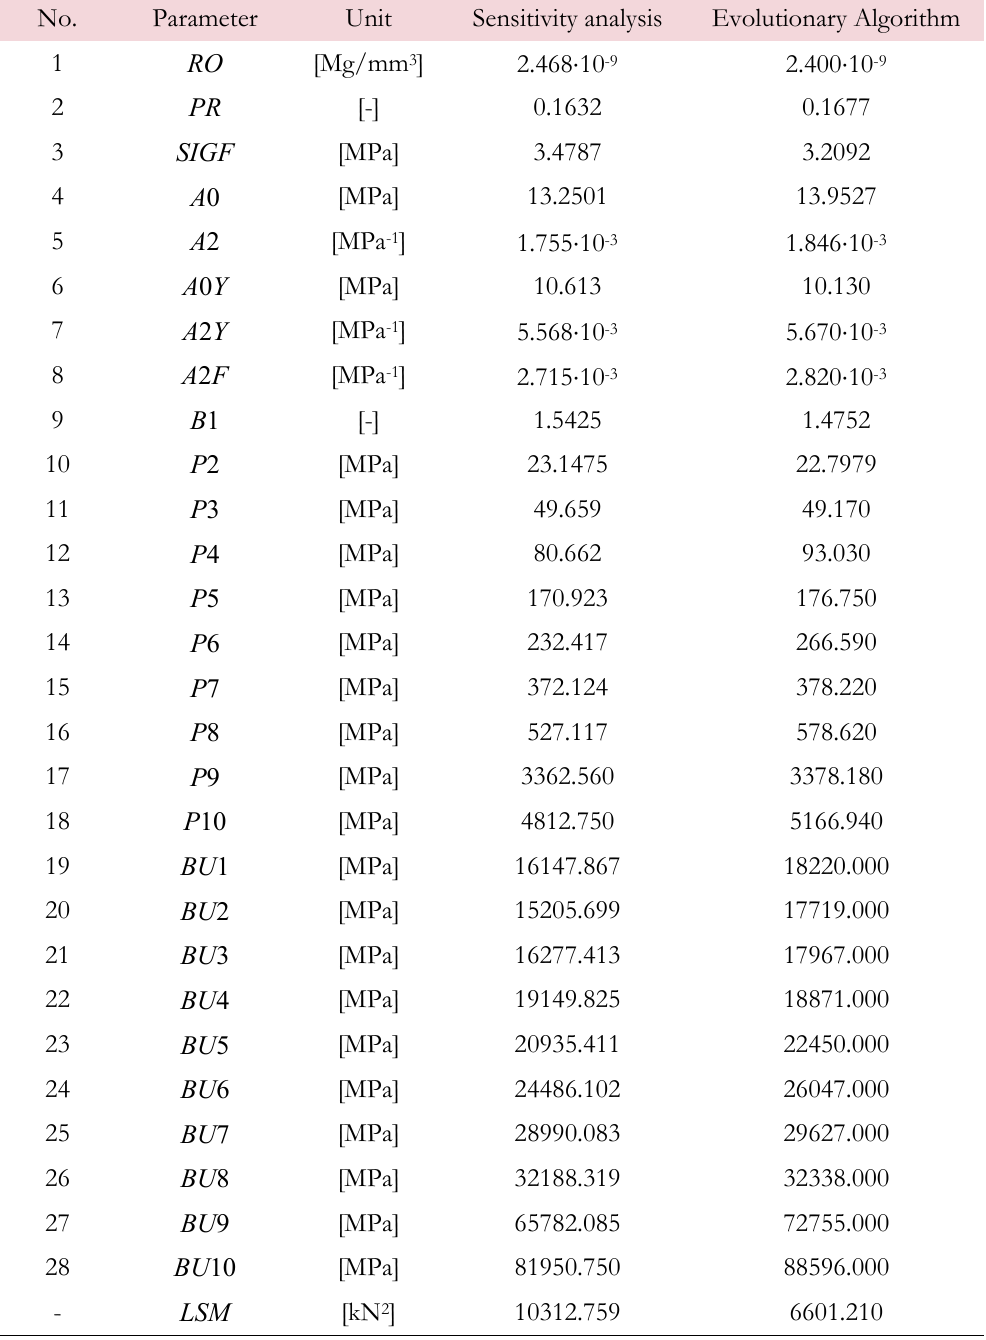
Table 2: The resulting identified material parameter values of the K & C Concrete model, obtained from the inverse